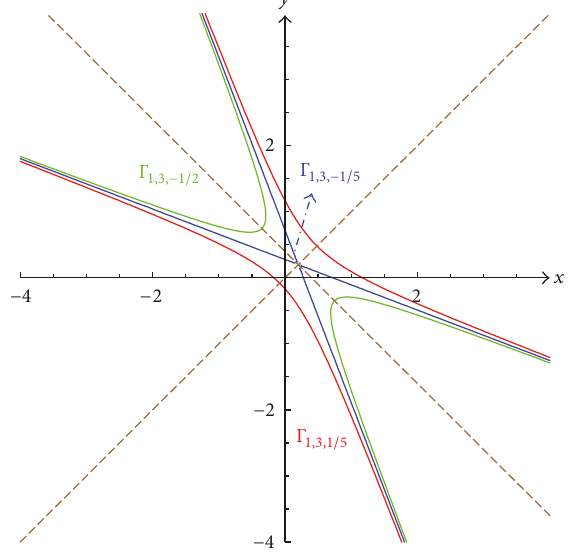
Figure 3: The hyperbolae with 𝜌 > 2